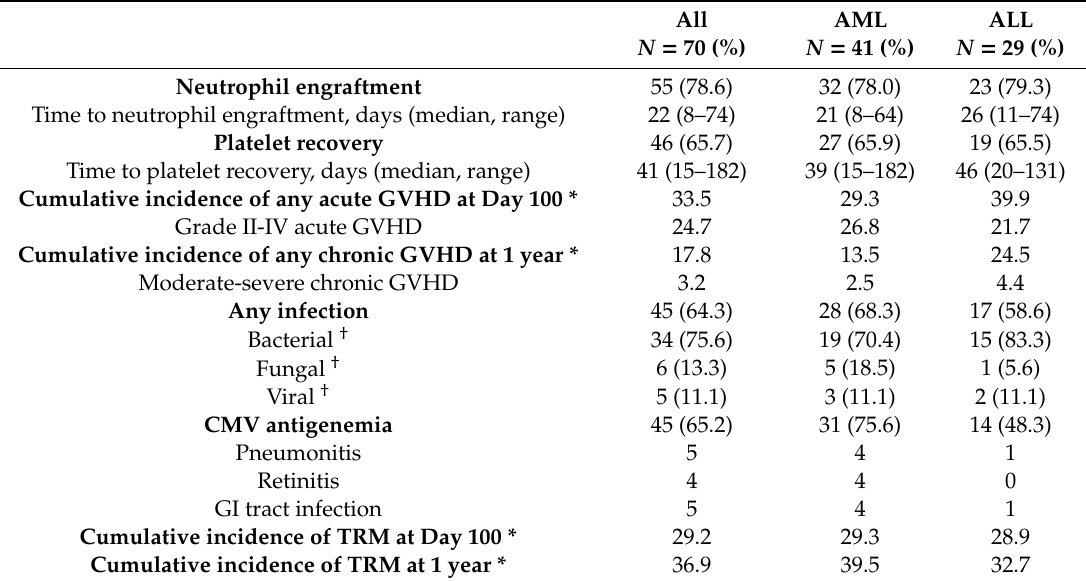
Table 2. Transplantation